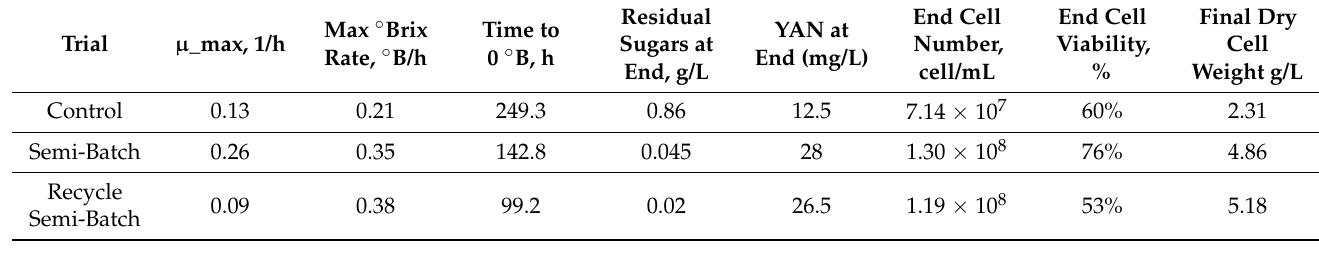
Table 2. Pilot fermentation kinetics.